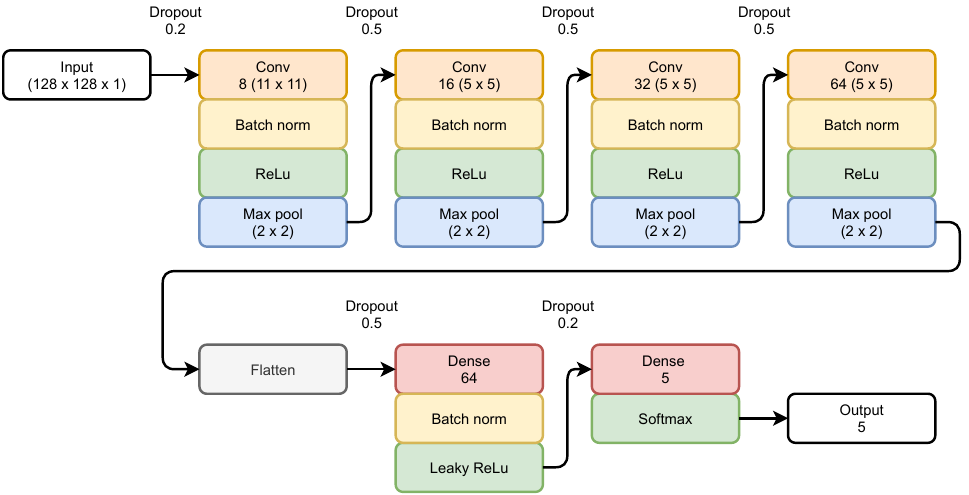
Figure 4. Fine estimation CNN architecture. Each block represents a different part of the CNN: red—convolution layer, orange—batch normalization, green—activation function, blue—pooling layer, magenta—dense layer, white—input and output